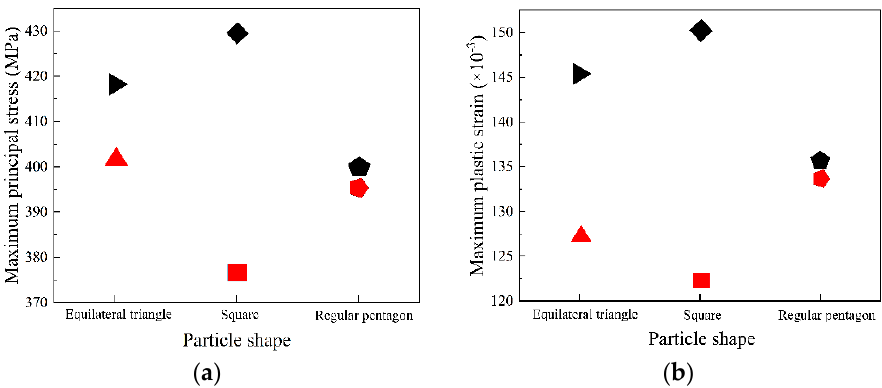
Figure 3. Schematic diagram of maximum principal stress and maximum plastic strain in compo- sites with the same particle shape but different particle orientations: ( a ) maximum principal stress; ( b ) maximum plastic strain.